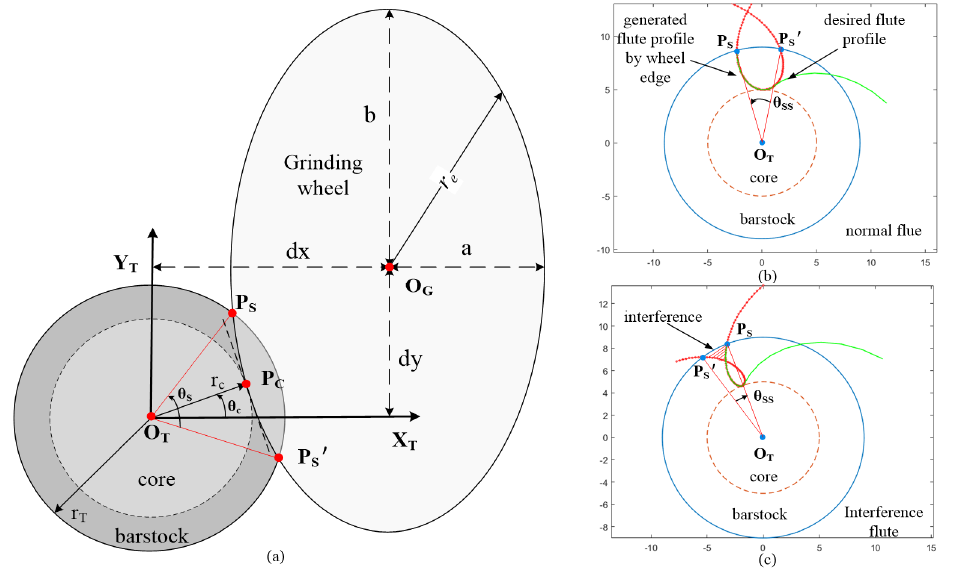
Figure A1. Flute-grinding projected in the cross-section: ( a ) the projection model; ( b ) normal flute; ( c ) interference flute.